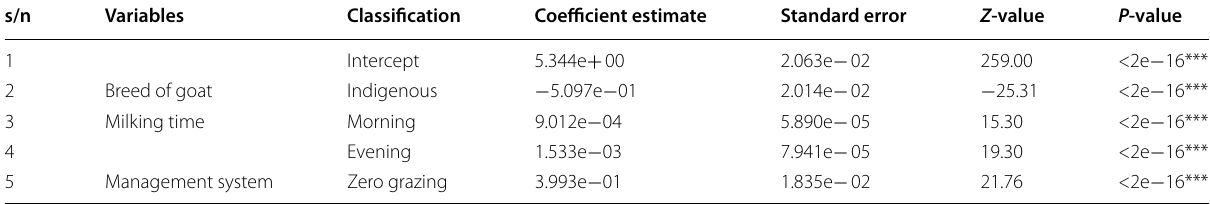
Note: For the goat breed and management system, the intercept represents the blended goat and free-range systems,